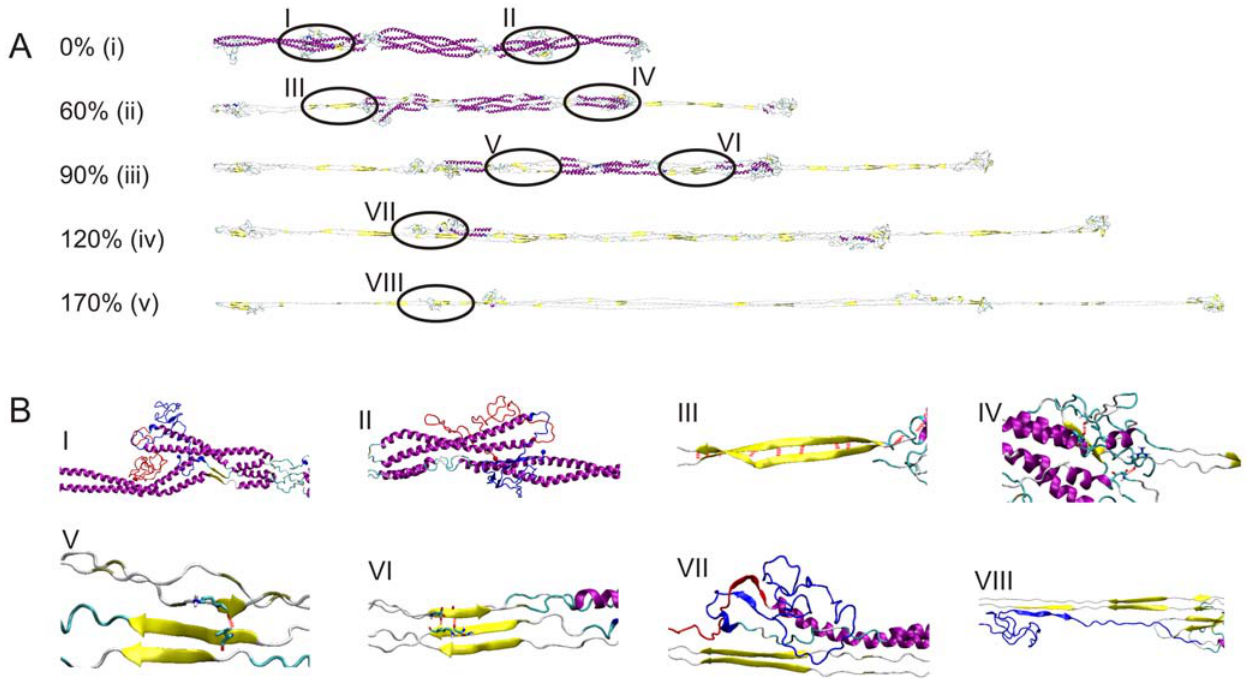
Figure 7. Simulation snapshots and structural analysis during pulling of the tetramer. Panel A displays snapshots as the applied tensile strain is increased up to 170%. The a - b transition leads to significant thinning of the filament diameter (compare snapshot (i) with snapshot (v)). Panel B displays blow-ups of detailed atomic structures of the snapshots marked (I) to (VIII) in panel A.